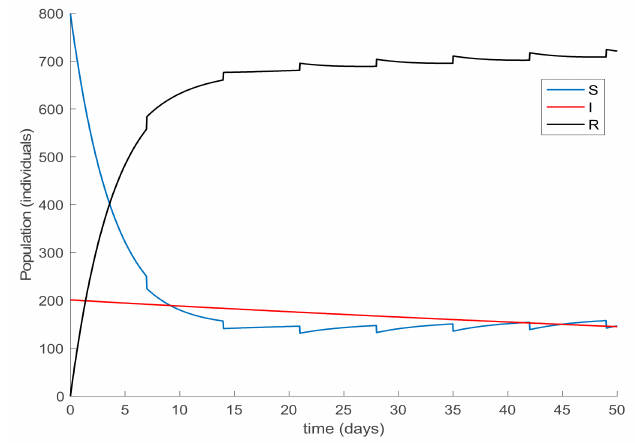
Figure 14. Evolution of all the subpopulations when an impulsive vaccination of susceptible individ- uals one day per week is added to the previous actions.